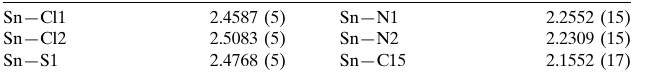
Selected bond lengths (A˚ ).